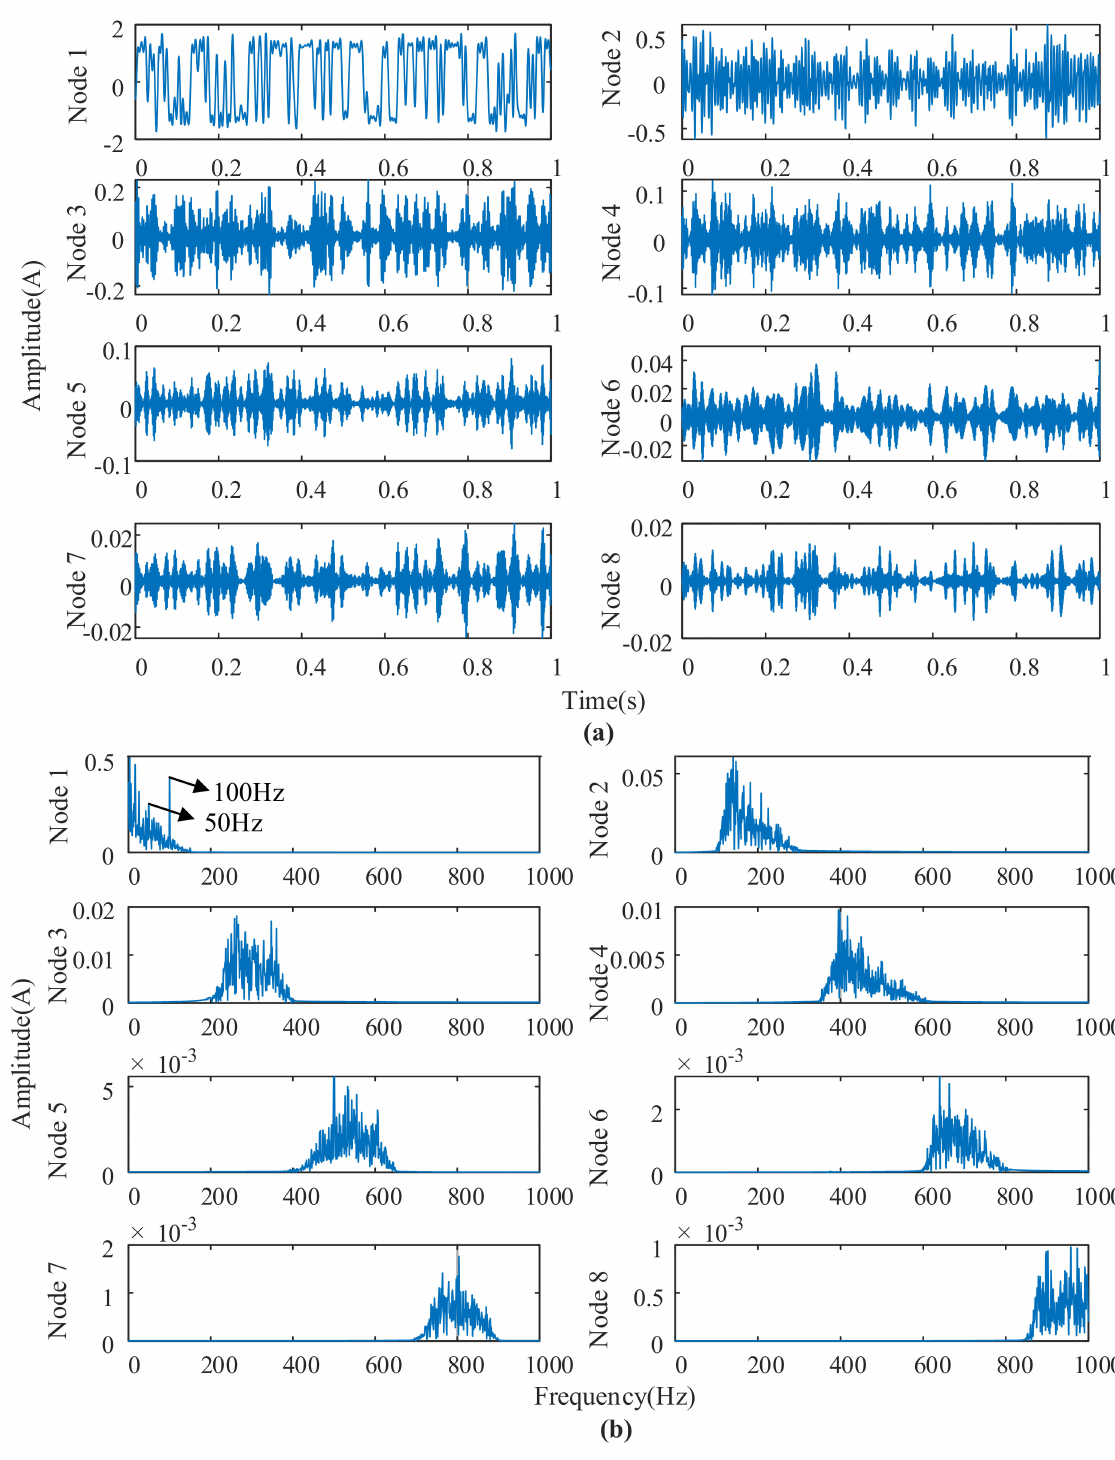
Figure 16. Wavelet packet coefficients after the second ACSRS: ( a ) Time − domain; ( b ) frequency